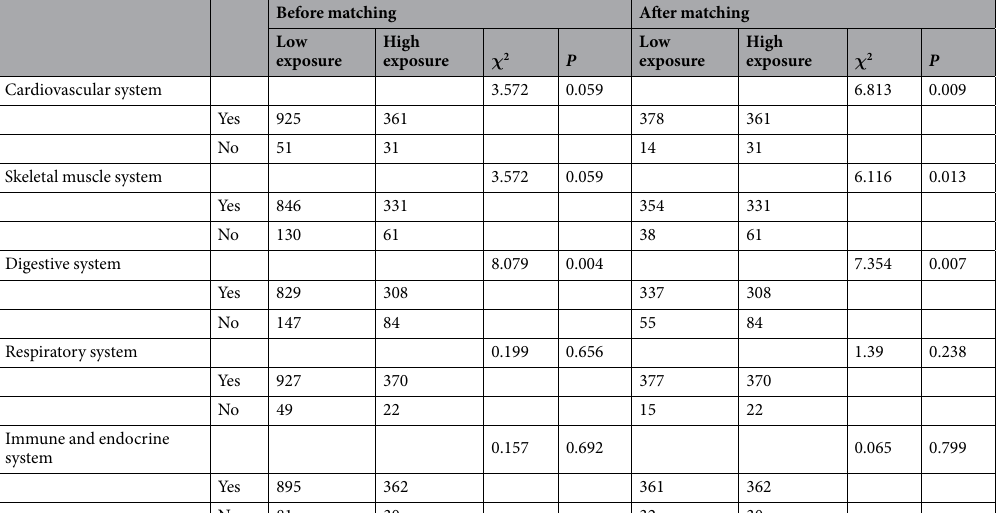
Table 3. Difference test of diseases in major human systems before and after matching between different exposure Groups.